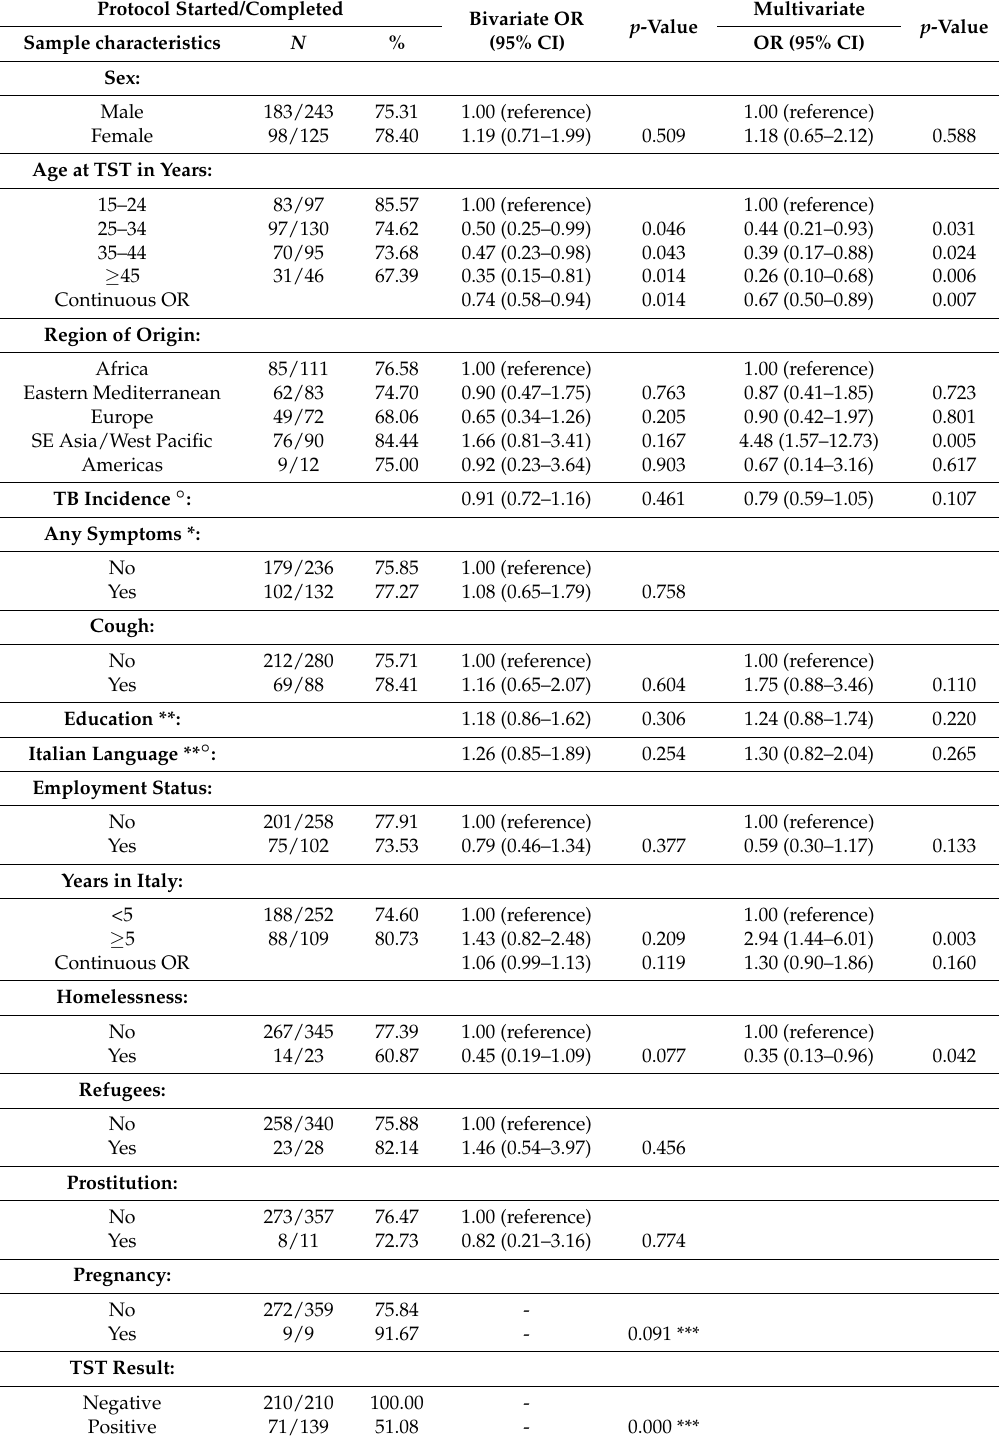
Table 4. Association between selected characteristics and compliance with the full protocol (bivariate and multivariate